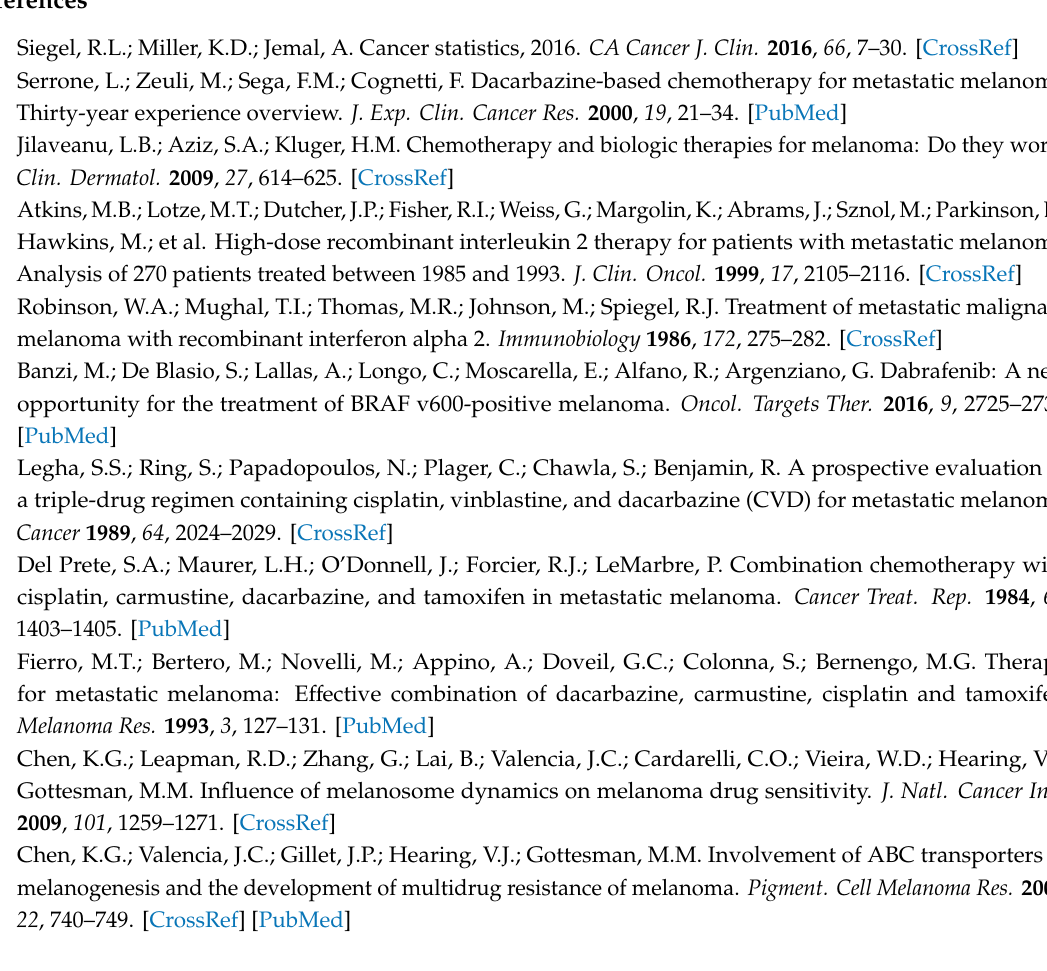
Figure S1: Phenotypes of the SIRT2-deficient melanoma cell lines, Figure S2: Venn diagrams to compare the identified DEGs from the di ff erent expression analysis tools and designate the shared DEGs, Figure S3: Individual cytotoxic e ff ects of dasatinib on melanoma cell lines, Figure S4: Computer-generated area lacking values to illustrate the in vitro scratch assay from Figure 3, Table S1: Gene ontology (biological process) term results from the PANTHER overrepresentation test for significantly di ff erentially expressed (DE) genes regulated in both melanoma cells analyzed, Table S2: Expression of selected genes in A375 melanoma cells after treatment with the SIRT2 inhibitor thiomyristoyl, DataSet S1: A complete list of genes that changed expression in WM853 cell line after SIRT2 downregulation determined using RNA-seq, DataSet S2: A complete list of genes that changed expression in MDA-MB-435S cell line after SIRT2 downregulation determined using RNA-seq, DataSet S3: A complete list of gene ontology (biological process) term results from the PANTHER overrepresentation test for significantly di ff erentially expressed (DE) genes regulated in WM853 SCW3 / WM853 SSW30 and MDA-MB-435S SCM1 / MDA-MB-435S SSM15 cells, Original scans of Figures 1, 5 and